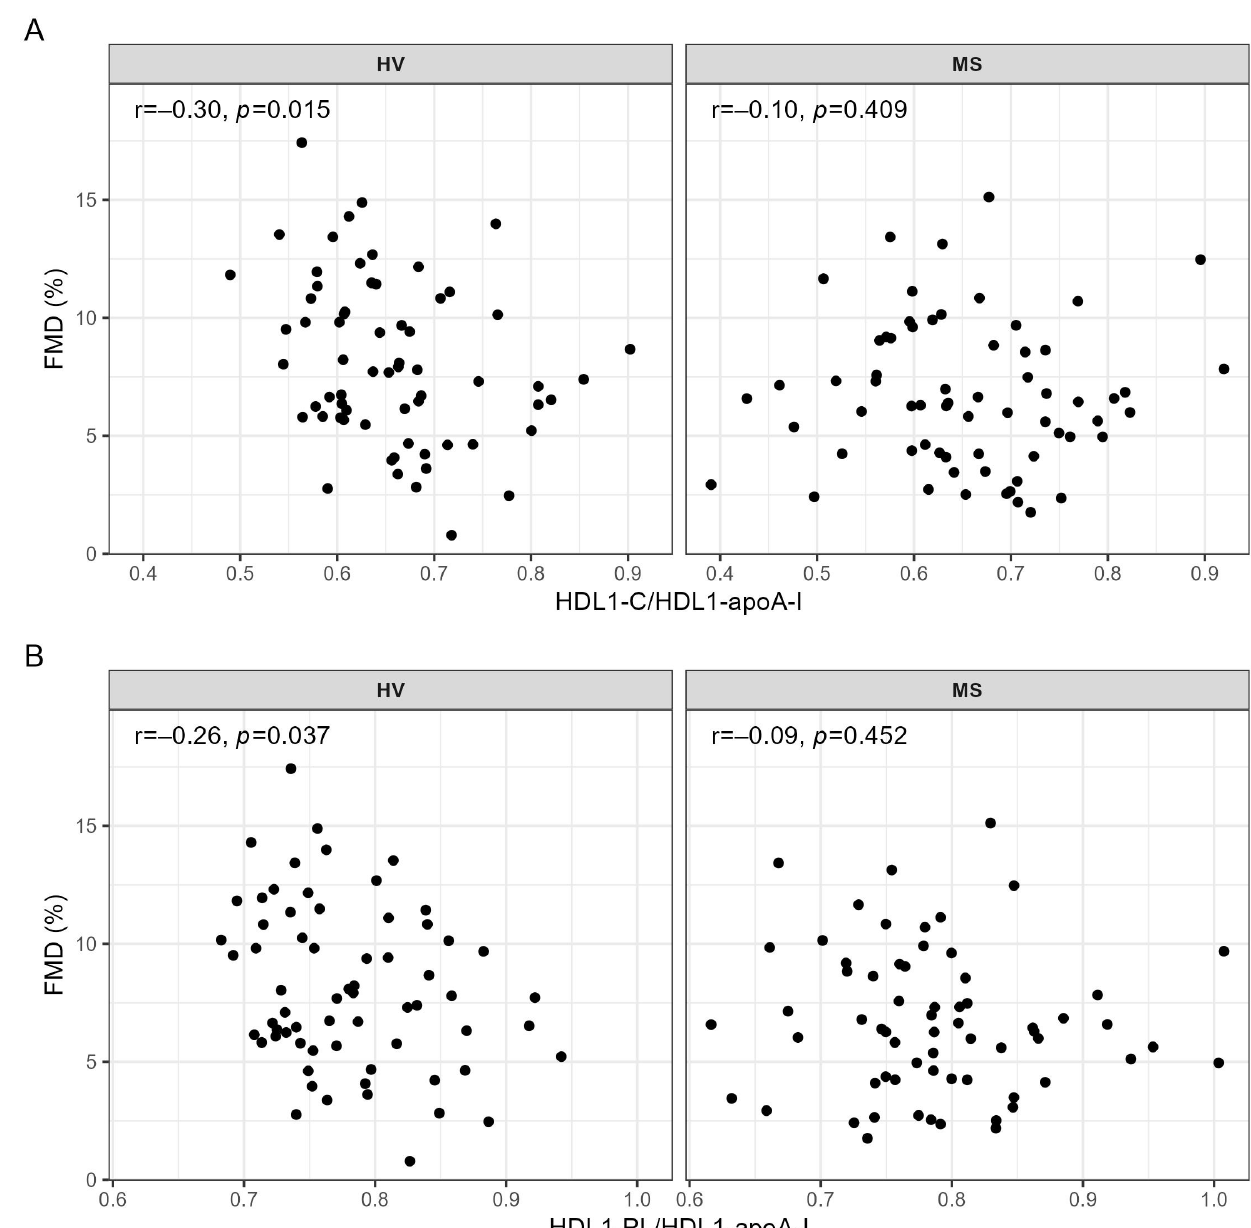
Figure 3. Correlations of ( A ) HDL1-C/HDL1-apoA-I and ( B ) HDL1-PL/HDL1-apoA-I with FMD in HV and MS patients. Correlations were quantified using Spearman’s correlation coefficient. ApoA-I, apolipoprotein A-I; C, cholesterol; HDL, high-density lipoprotein; HV, healthy volunteer; FMD, flow-mediated dilation; MS, metabolic syndrome patient; PL, phospholipid; r, Spearman’s correlation coefficient. 2.6. Correlation Analyses of EL with Metrics of Vessel Function, HDL Subclasses, Lipid Content, and